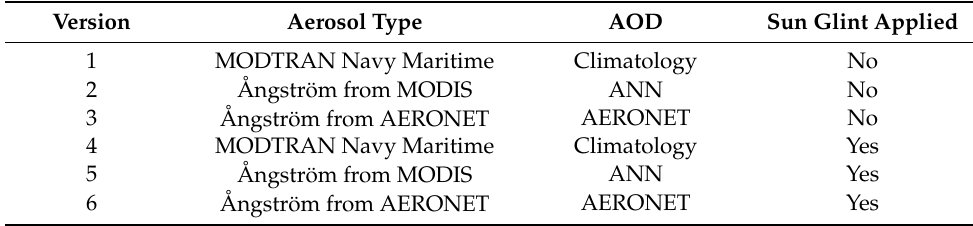
Table 3. Processing versions